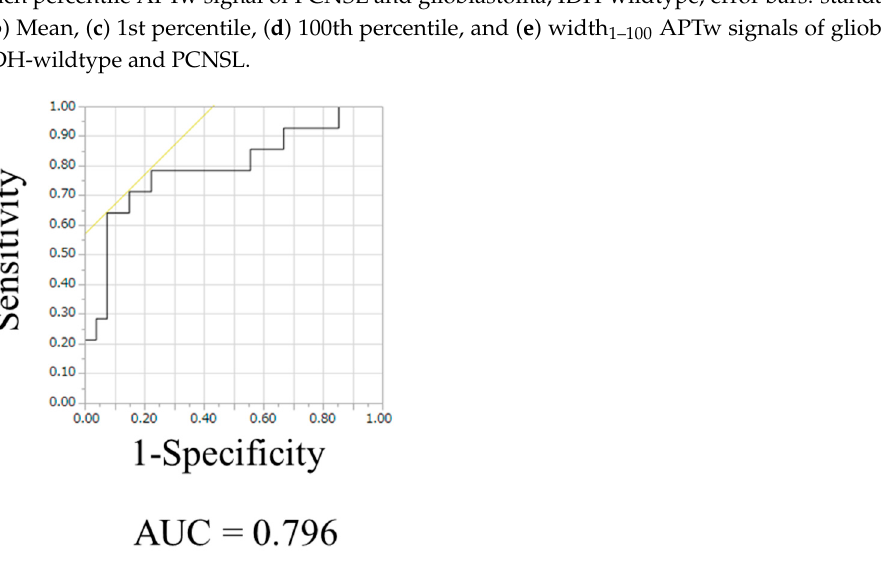
Figure 3. ROC of the width 1–100 APTw signal, showing an AUC of 0.796.